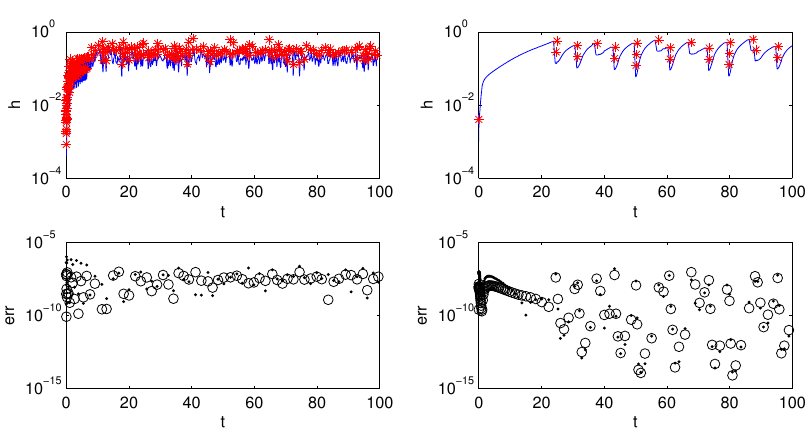
Figure 1. Results of method of order p = 3 with tolerance tol = 10 − 6 on problem (4.2). Top: Rejected steps (*) and stepsize pattern (solid line); bottom error estimations ( · ) vs local error ( ◦ ). Left: standard step changing strategy, right: PI controller. Error figures - every 5-th